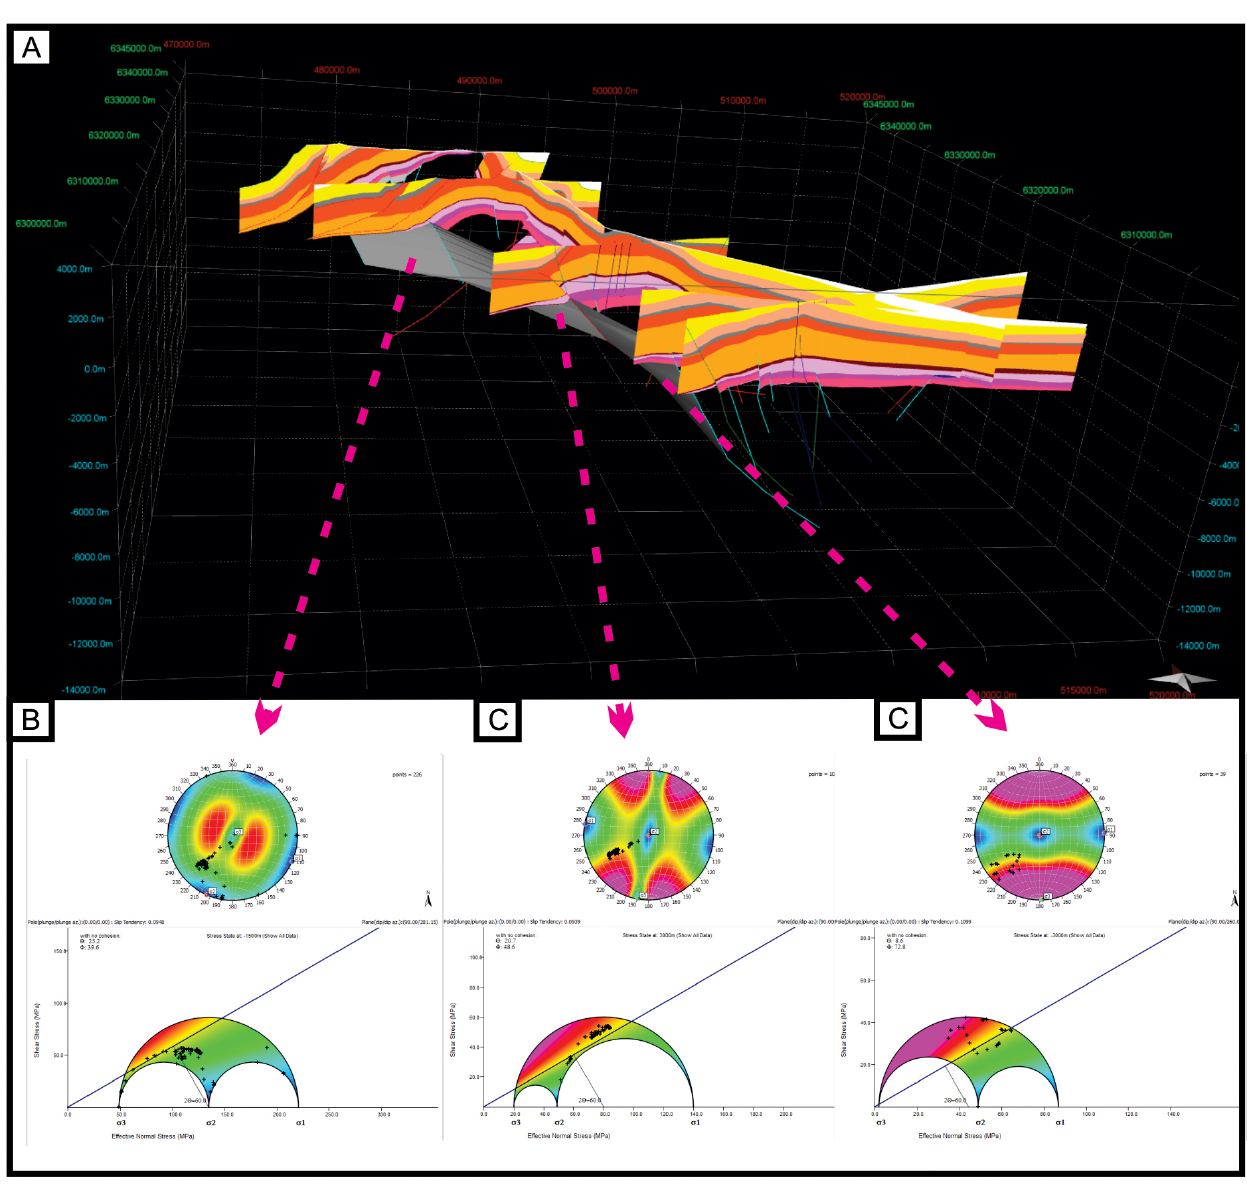
Figure 13. (a) 3-D model of the Cacheuta sub-basin area. The Triassic master fault is in grey. (b–d) Slip tendency analysis of the different segments – northern, central and southern – composing the Higueritas and Anchayuyo Norte master faults, for values of pore overpres- sure = 20MPa, µ = 0.6 and σ 1 /σ 3 = 3.1. The NNW-striking master fault (grey plane) is more likely to slip under reverse/strike-slip